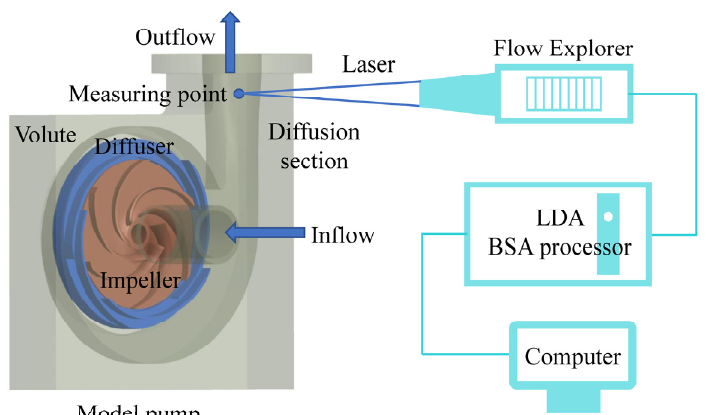
Figure 3. LDA experiments of the transparent